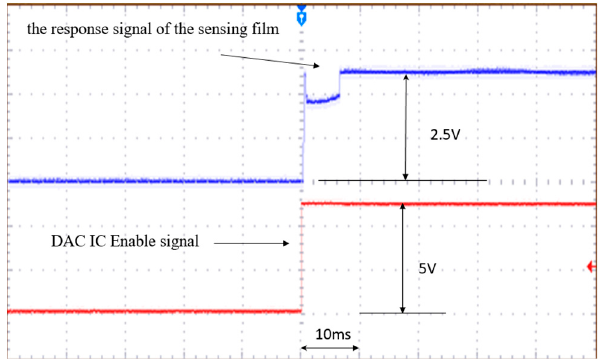
Figure 6. Reaction time of the microheater for proposed driving method. Red line is the DAC Enable signal and blue line is proportional to the response of the sensing film.